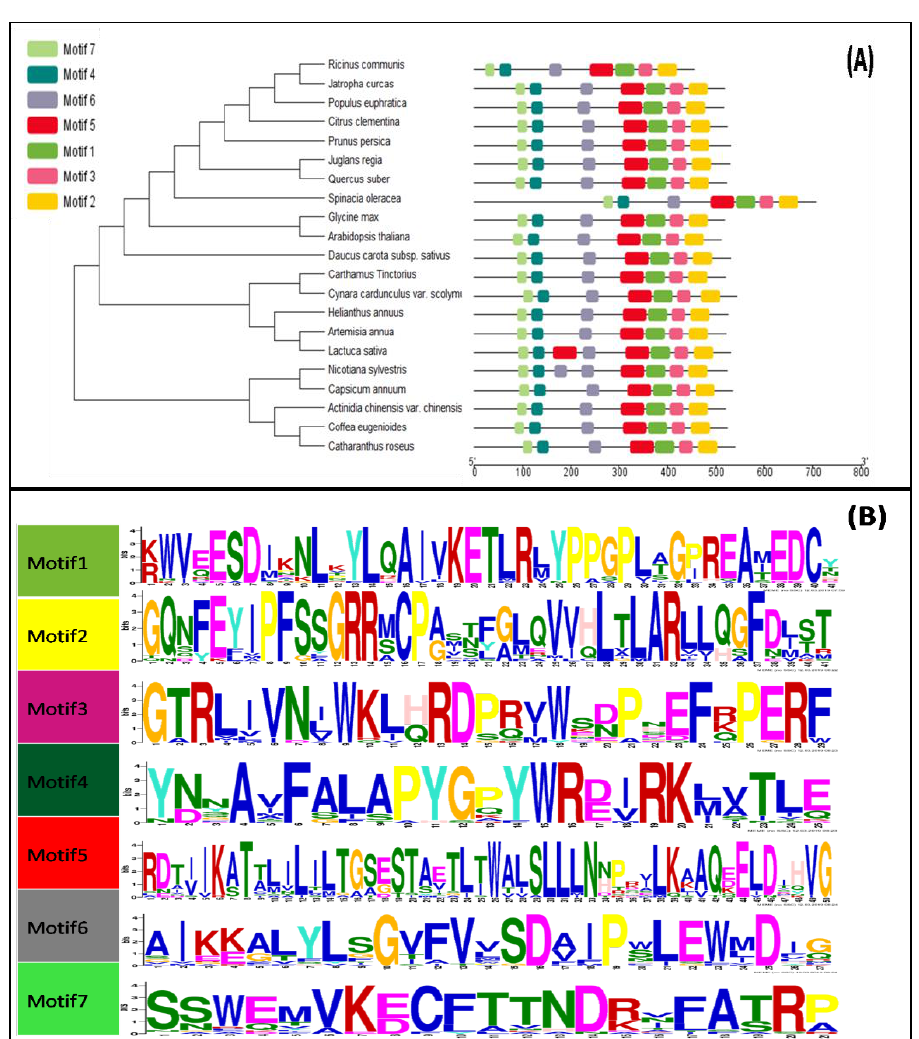
Figure 1. Phylogeny analysis and identification of the conserved domains ( A ) Phylogenetic analysis using the 1000 rapid bootstraps method was created with the MEGAx online tool. The online tool of the MEME server was used to identify the conserved motifs. The green, yellow, pink, blue, red, grey and light green colors represent motifs 1, 2, 3, 4, 5, 6 and 7, respectively. The indication of the grey line length denotes the sequence length. The presence of each block at multiple positions determines the location of the conserved motif to its matching one. The tree and motifs parameters were edited using the EVOLVIEW online tool ( B ) Conserved motif compositions and the representation of logos. The capital letters in the logos of individual motif represent more than 70% ratio of the conserved amino acids. The Arabic numerals appear beneath uppercase letters and indicate the width of the conserved motif.